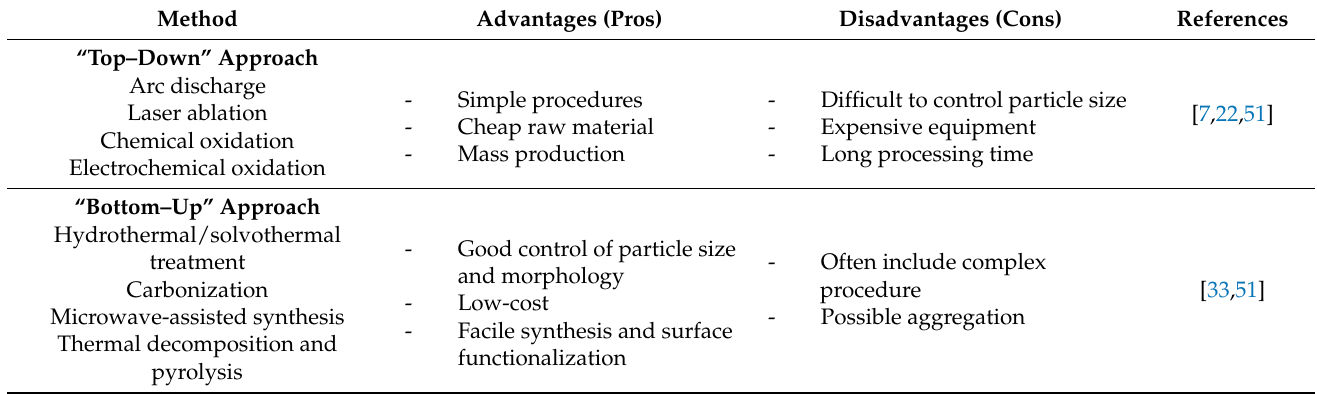
Table 1. Summary of advantages and disadvantages of CQDs synthetic